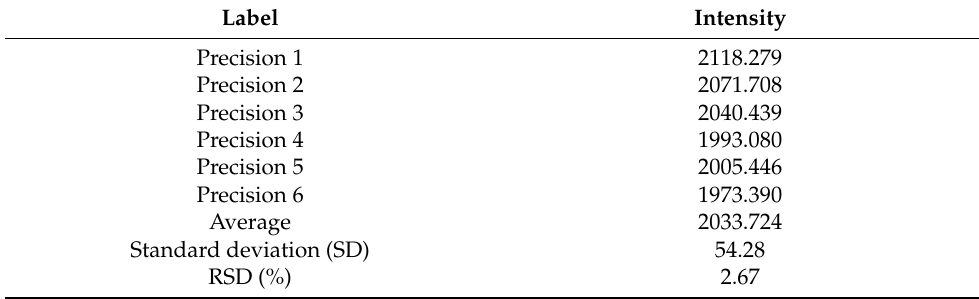
Table 1. Precision test of the method used.